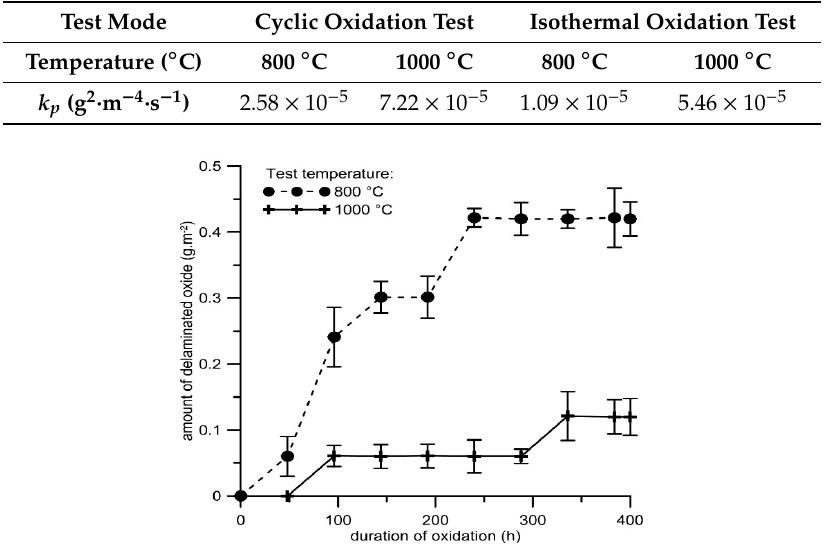
Figure 8. Dependence of the amount of delaminated oxide (g · m − 2 ) on duration of cyclic oxidation at ◦ C in air for FeAl20Si20 800 and 1000 °C in air for FeAl20Si20 alloy. 800 and 1000